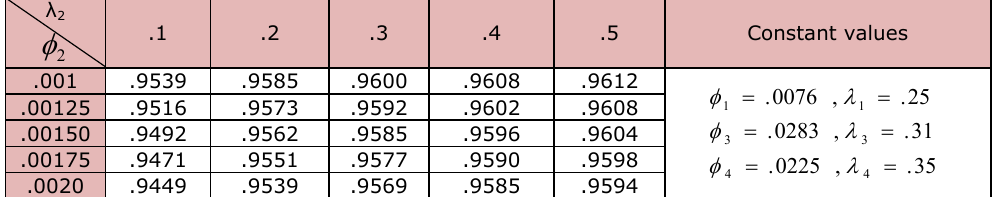
Table 2. “Availability matrix of ESP subsystem of Flue gas and air system”.